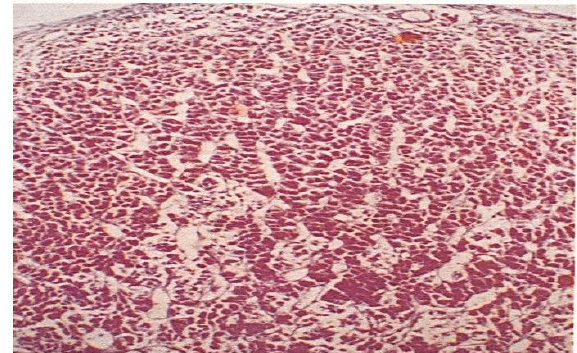
Figure,4: Fetal goat adrenal cortex CRL=40cm/140 day ; The capsule 0f adrenal gland consist of dense C.T. Blood vessels are seen . Zone fasciculation cells and reticularis are increased in number and size , yellow in color. Medulla is found in the middle of section. (M.H.